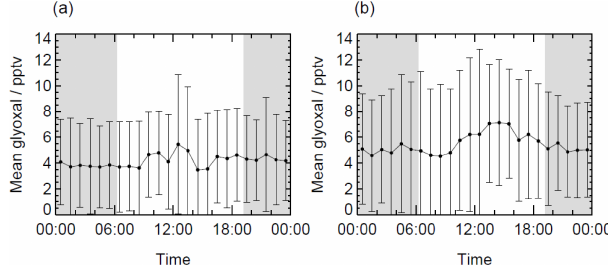
Figure 6. The 1h average diurnal profiles of glyoxal during (a) campaign 1 and (b) campaign 2. Error bars represent the 1 σ stan- dard deviation of the measurements. Grey shading indicates hours of